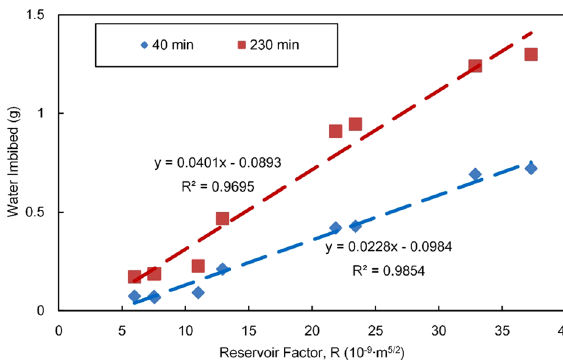
Figure 8. Water imbibition versus the reservoir factor